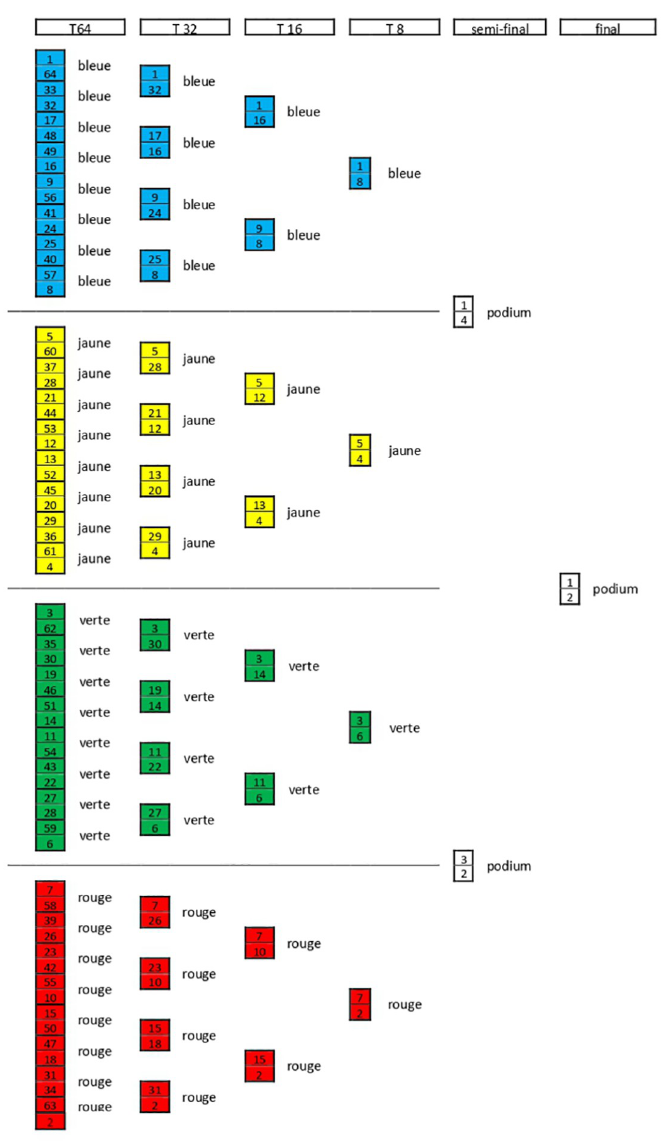
Fig 1. Sketch of the direct elimination table of a typical competition round, from 64 up to the final, scaling with decreasing powers of 2. Different colours identify different pistes. For clarity of the picture, larger tables (128, 256) have been